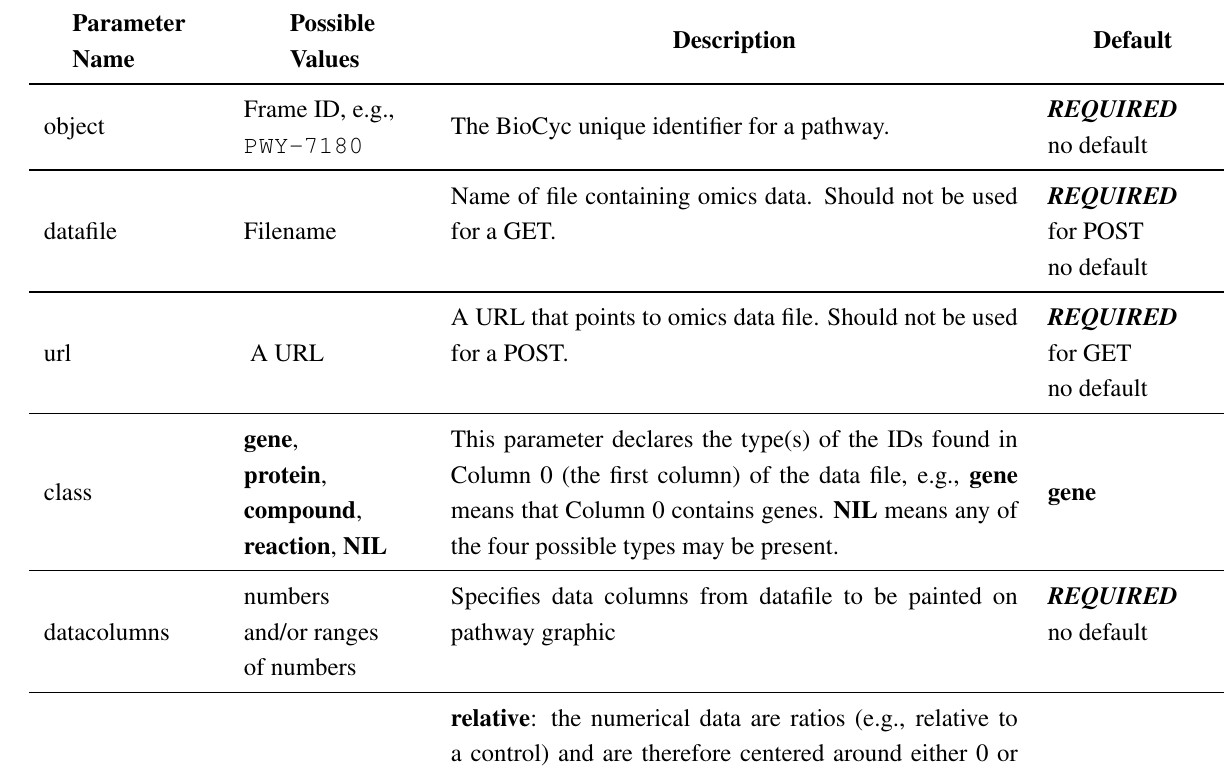
Table 2. Parameters to customize pathway omics-data